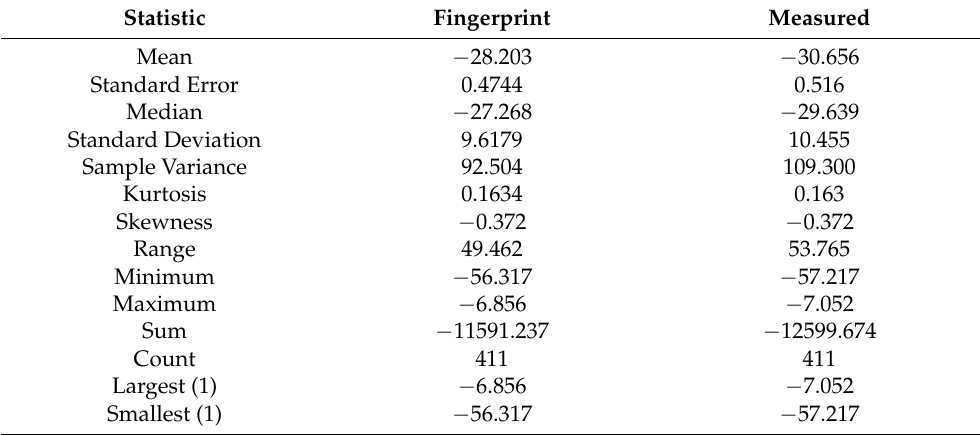
Table 15. Sub-region 3: Descriptive statistics comparison between fingerprint and measured FRA